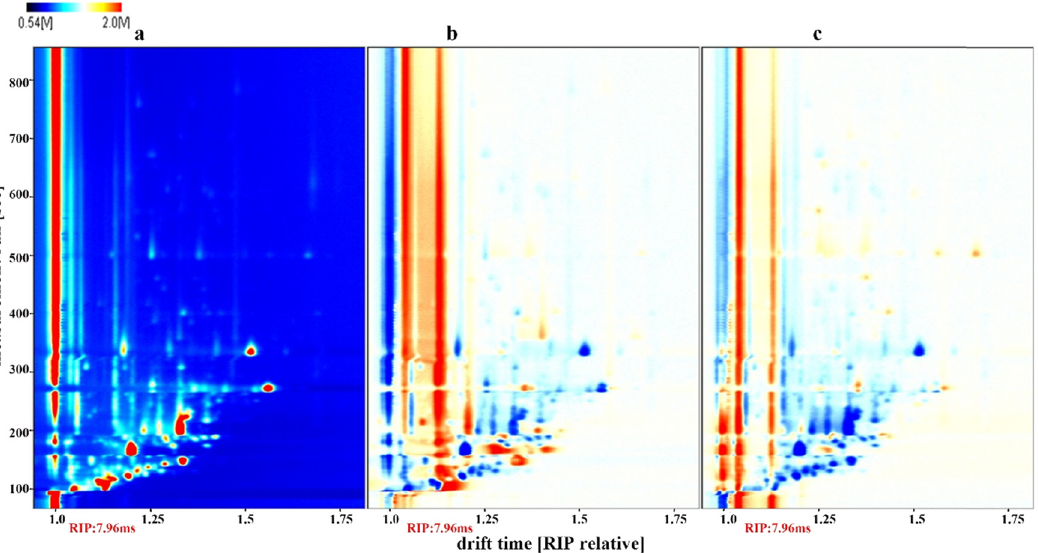
Figure 2: 3D - topographic ( top view ) of di ff erent extraction methods: ( a ) squeezing extracted; ( b ) supercritical carbon dioxide extracted; ( c ) aqueous